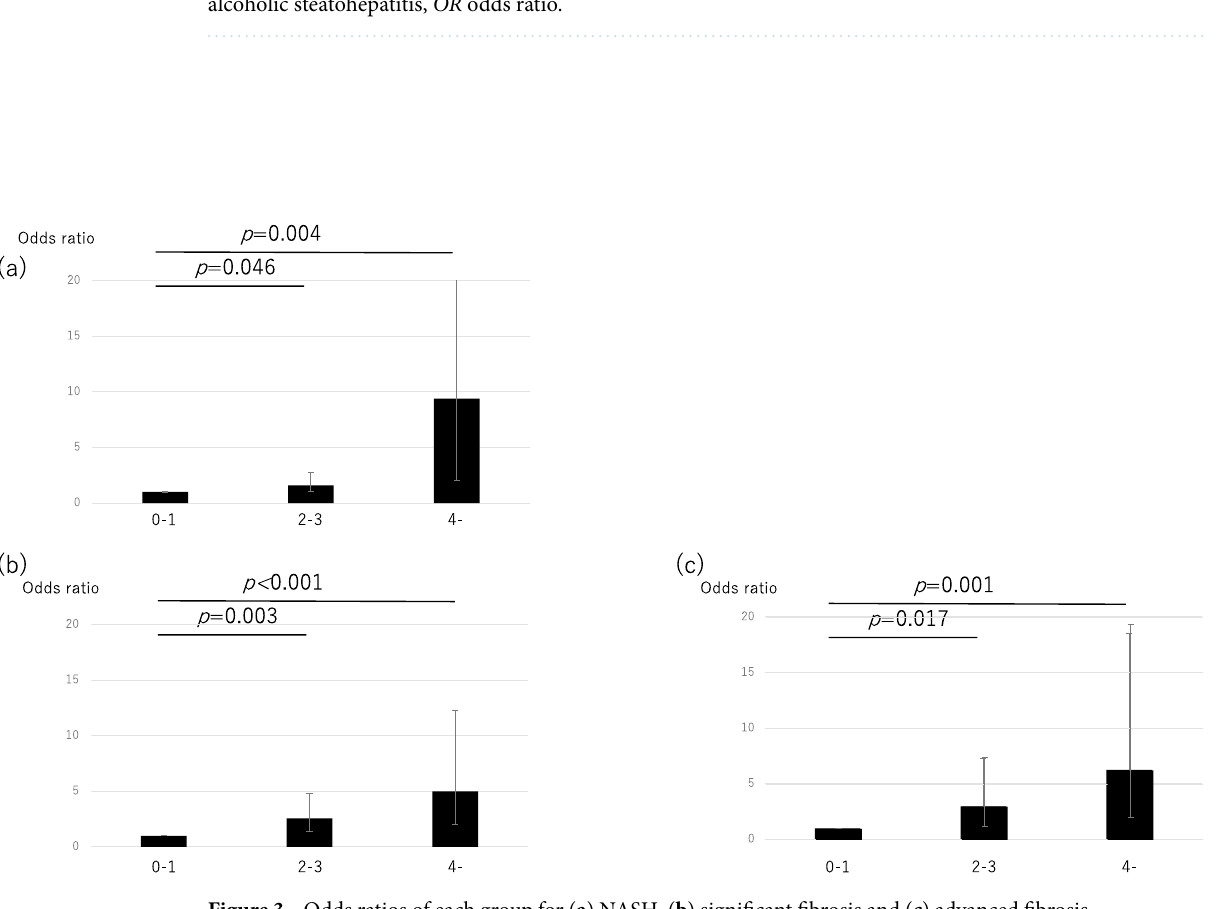
Figure 3. Odds ratios of each group for ( a ) NASH, ( b ) significant fibrosis and ( c ) advanced